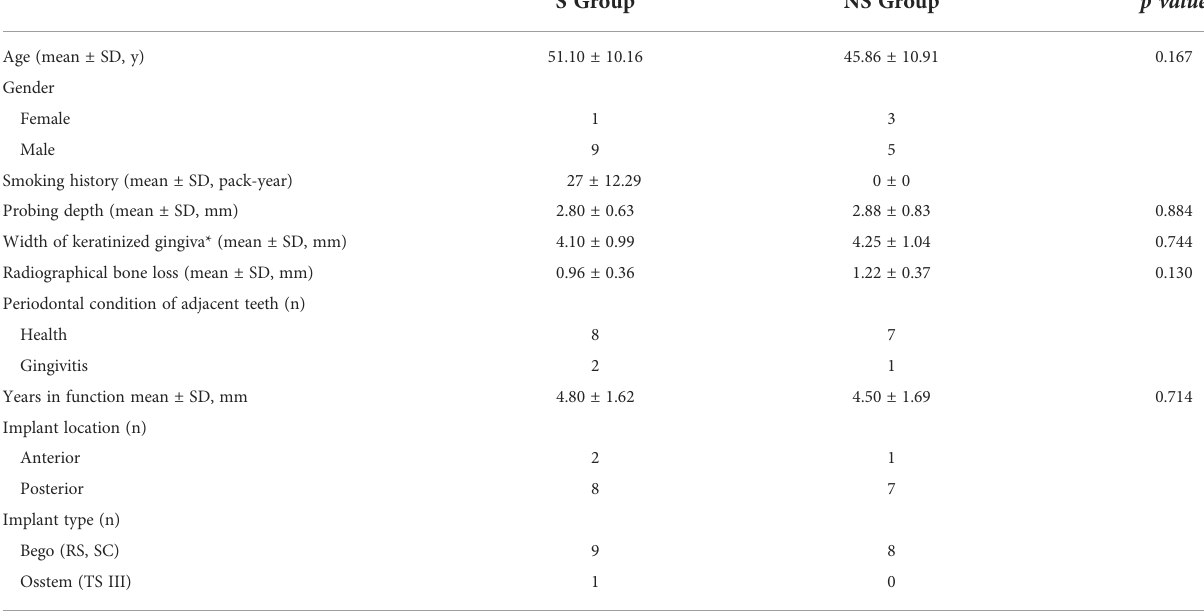
TABLE 2 Clinical and demographical characteristics between Smoker (S) and Non-Smoker (NS)